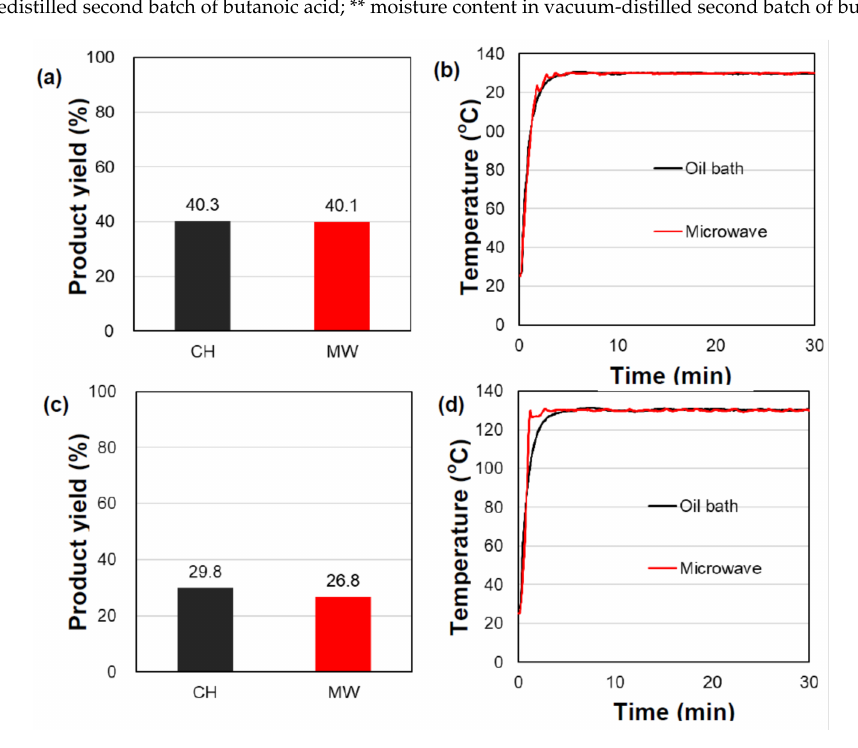
Figure 3. ( a , c ) Product yields and ( b , d ) internal temperature profiles in the synthesis of the heptyl butanote ester using oil-bath heating (CH) and microwave heating (MW) in a homogeneous phase with the catalyst TMP-PTS: ( a , b ) the moisture content in the predistilled butanoic acid batch was 0.022% (second experiment run) and ( c , d ) the moisture content in the butanoic acid batch after the vacuum distillation was 0.058% (third experiment run).